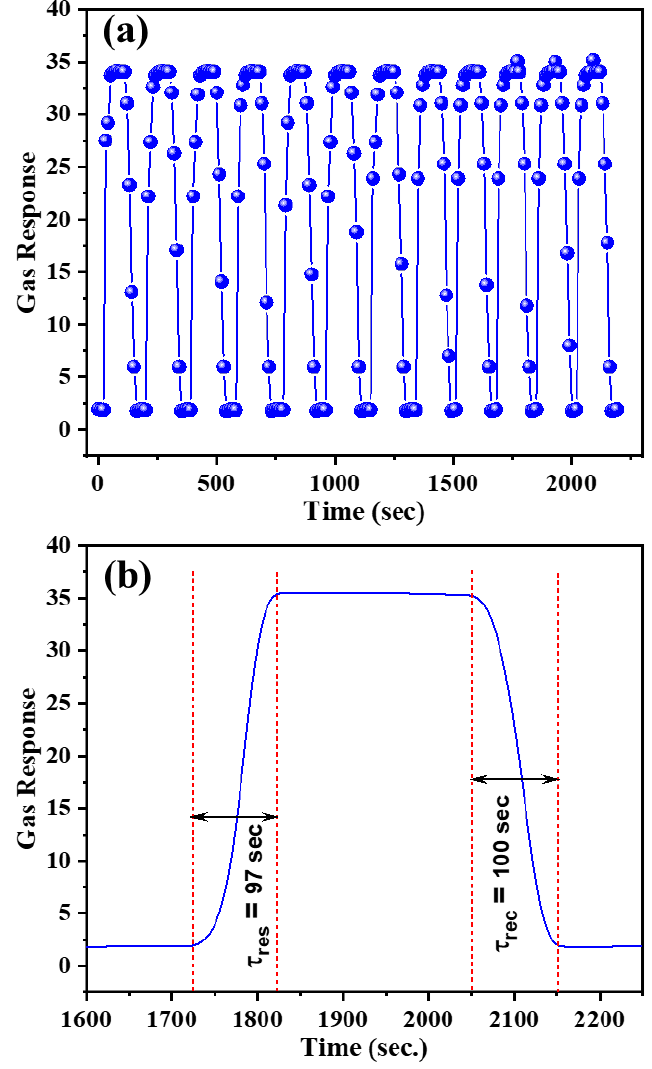
Figure 6. ( a ) Reproducibility study and ( b ) Response curve for the calculation of response and recovery times.